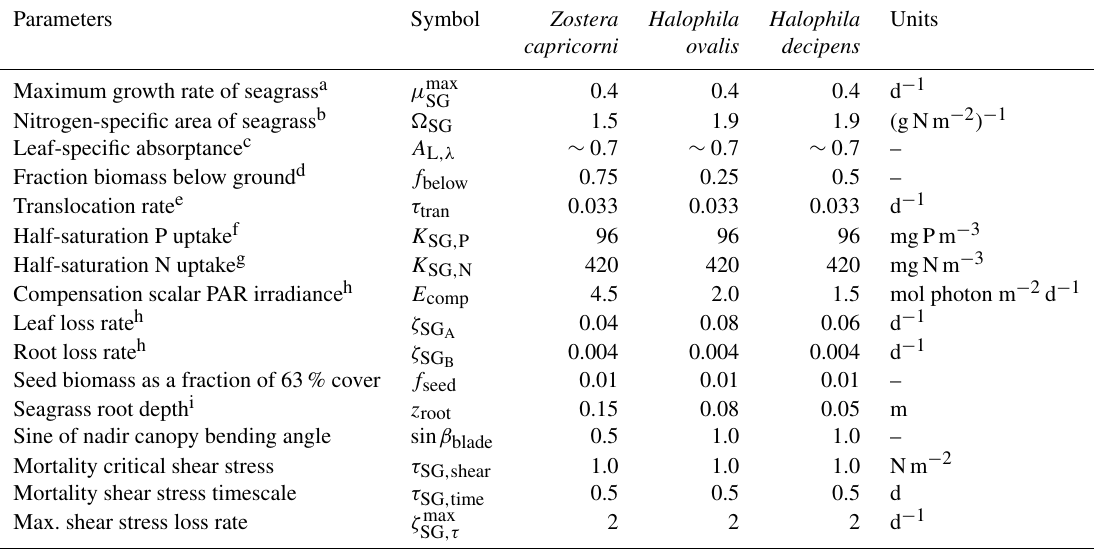
Table 23. Constants and parameter values used to model seagrass. a Factor of 2 for nighttime, factor of 2 for roots. b Zostera is calculated from leaf characteristics in Kemp et al. (1987); Hansen et al. (2000); Halophila ovalis is calculated from leaf dimensions in Vermaat et al. (1995); (cid:127) SG can also be determined from specific leaf area such as determined in Cambridge and Lambers (1998) for nine Australian seagrass species. c Spectrally resolved values in Baird et al. (2016a). d Duarte and Chiscano (1999). e Loosely based on Kaldy et al. (2013). f Thalassia testudinum (Gras et al., 2003). g Thalassia testudinum (Lee and Dunton, 1999). h Chartrand et al. (2012); Longstaff (2003); Chartrand et al. (2017). i Roberts (1993).